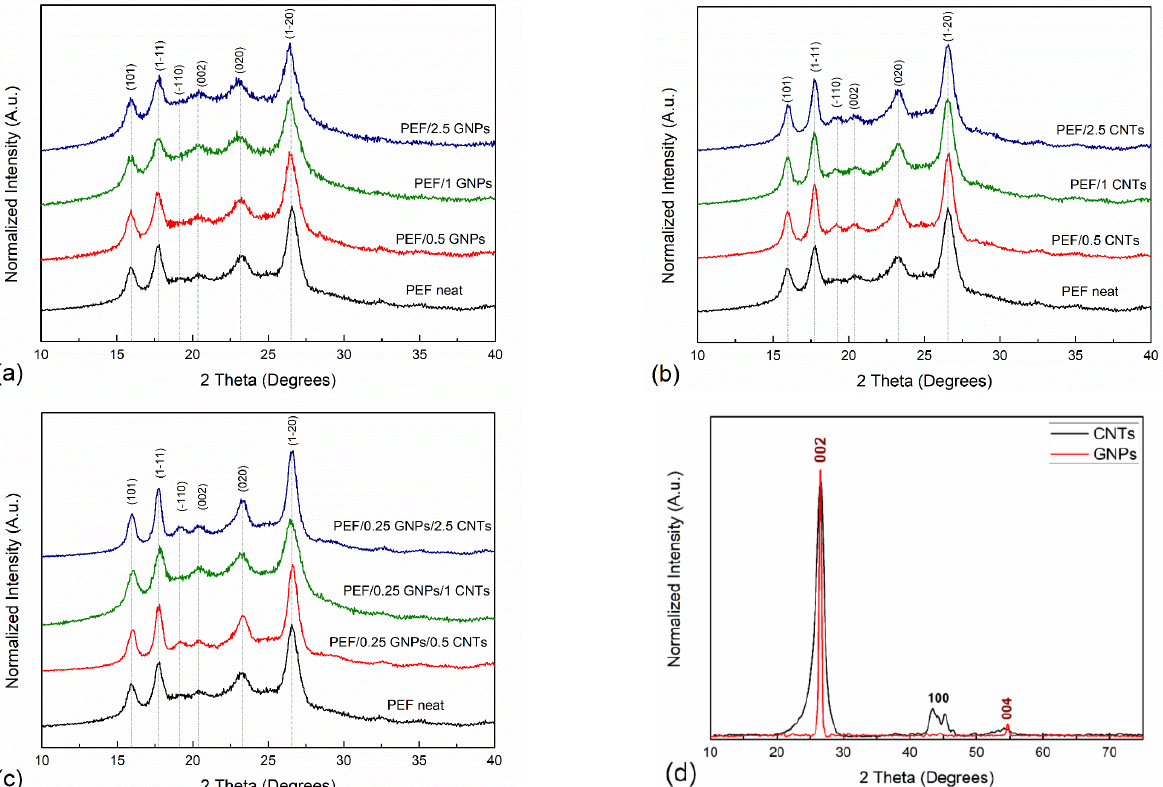
Figure 1. XRD patterns of neat PEF with ( a ) PEF/GNPs, ( b ) PEF/CNTs, and ( c ) PEF/0.25 GNPs/CNTs nanocomposites, and ( d ) the diffractogram of the incorporated GNPs and CNTs.